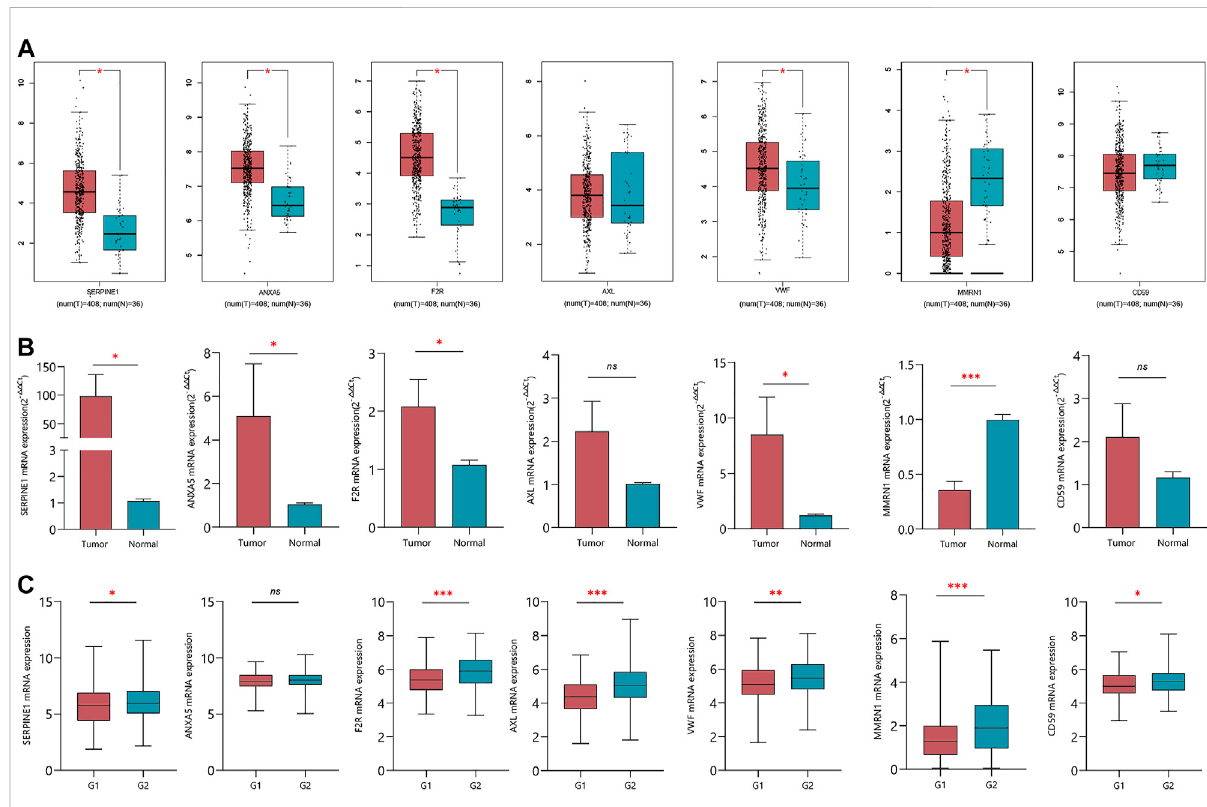
FIGURE 8 Veri fi cationoftheexpressionofsevenCRGsinnormalandtumortissues. (A) mRNAexpressionofsevenCRGsinGEPIAonlinetool. (B) qRT-PCR veri fi ed the expression of seven CRGs in 10 pairs of GC clinical samples. (C) mRNA expression of seven CRGs in G1 and G2